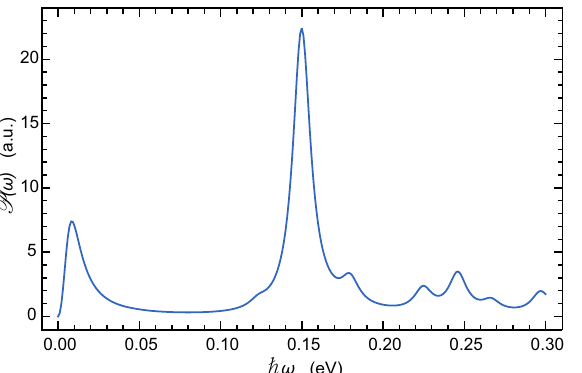
Figure 13. Absorbed power in arbitrary units, P ( ω ) , in the case of model 1, versus photon energy, ¯ h ω , in